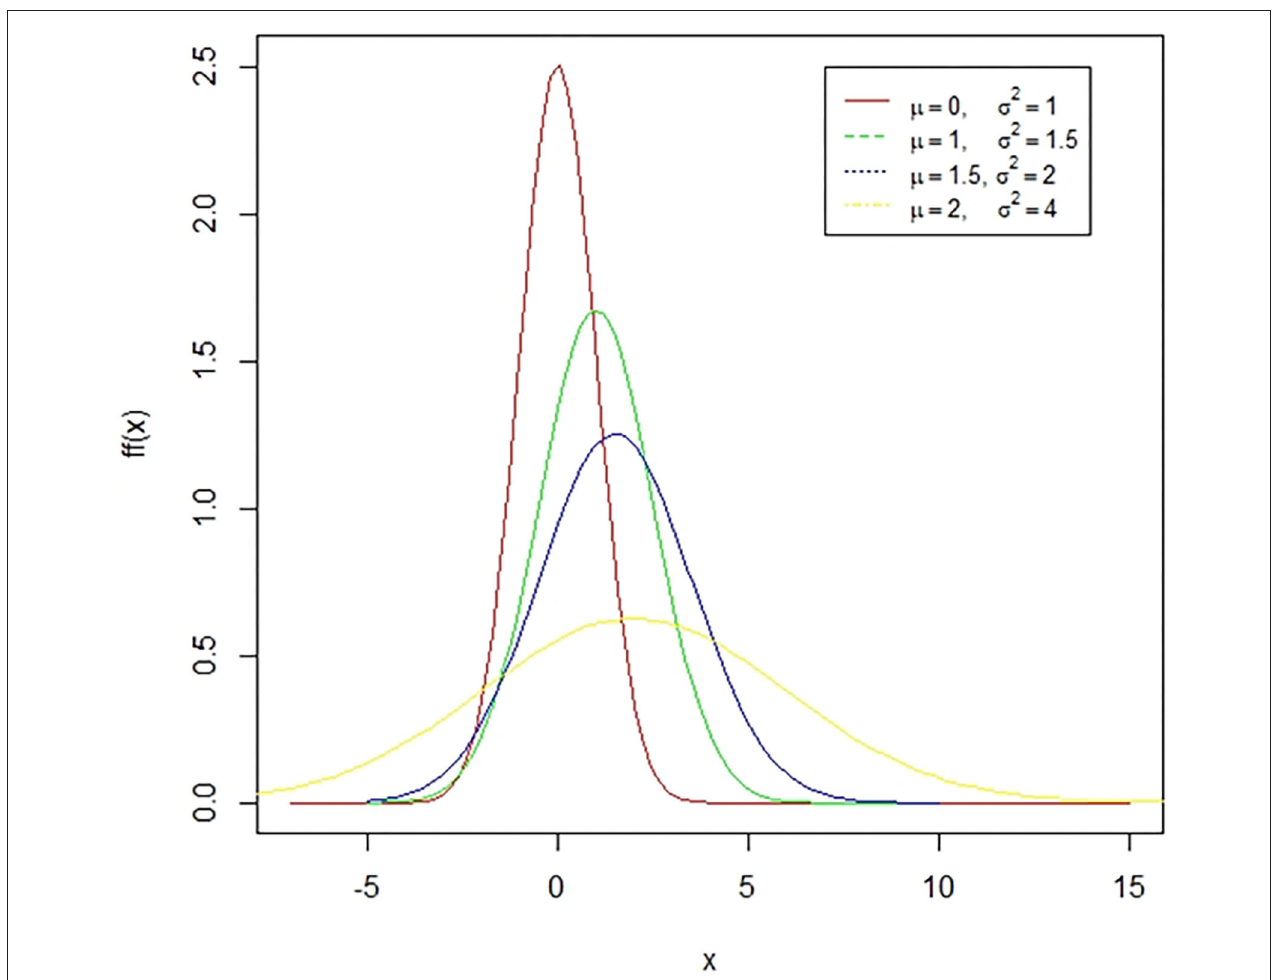
FIGURE 1 | A case of normal distribution. The normal distribution is a symmetric bell-shaped curve. The standard normal distribution has a mean zero and a standard deviation of one. The coefficient of skewness for this distribution is zero while the coefficient of kurtosis is three. The presented figure represents different normal curves for different values of means and